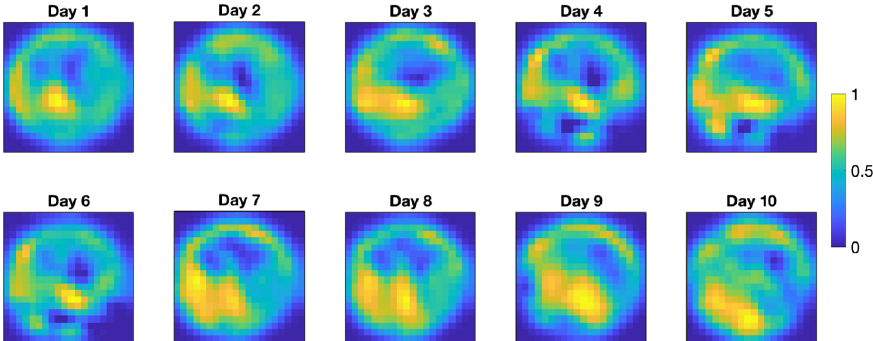
FIG. 8. Reconstruction of LCLS data by day. Reconstructions are relative to the center of the laser beam, so a shift in beam centroid on the cathode will correspond to a shift in the reconstructed cathode QE. There is a consistent hotspot just below and to the left of the laser centroid. As in Fig. 7, some of the high-resolution features may be due to systematic errors originating from the laser profile. Moreover, the strong circular ring of high QE at the edge of the laser aperture may be an artifact from the reconstruction algorithm. Subtle QE variations day-by-day may be real due to steering mirror movement (see Fig.